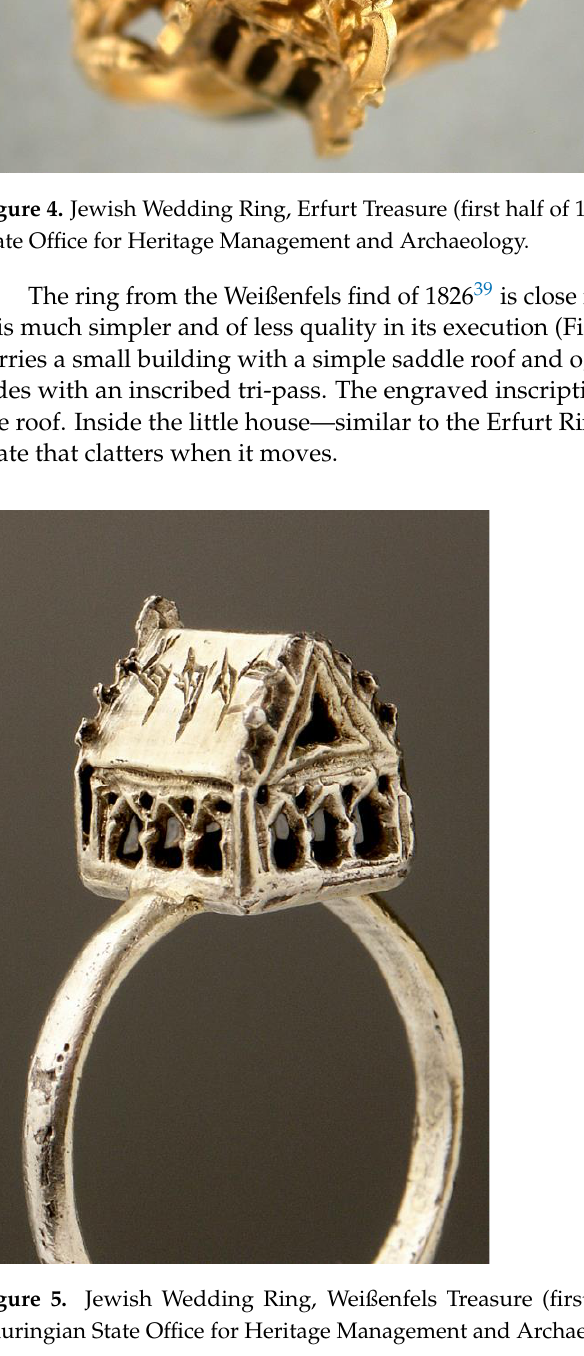
Figure 5. Erfurt Ring. Figure 5. Jewish Wedding Ring, Weißenfels Treasure (first half of 14th Century), © B. Stefan, Thuringian State Office for Heritage Management and